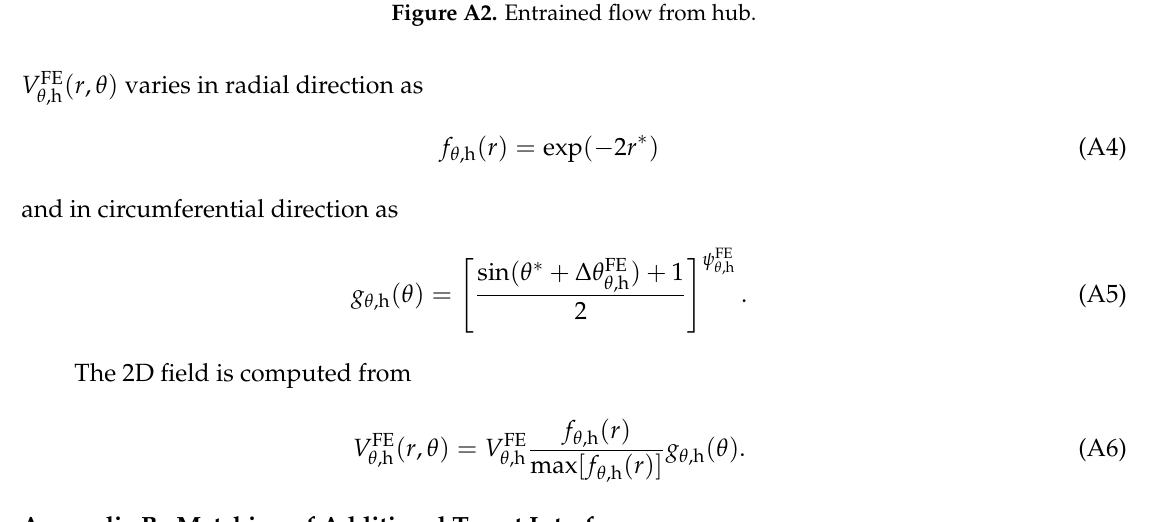
Figure A2. Entrained flow from